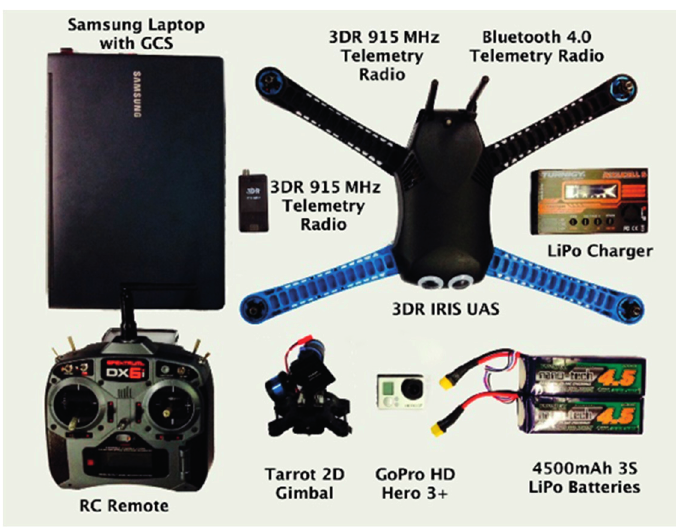
Figure 9. Equipment used for flight